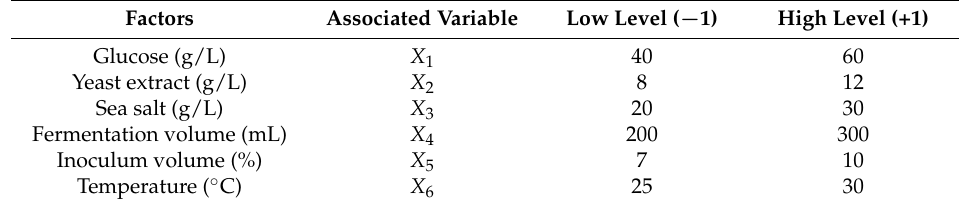
Table 1. Factors and experimental domain for the screening with Plackett-Burman design.